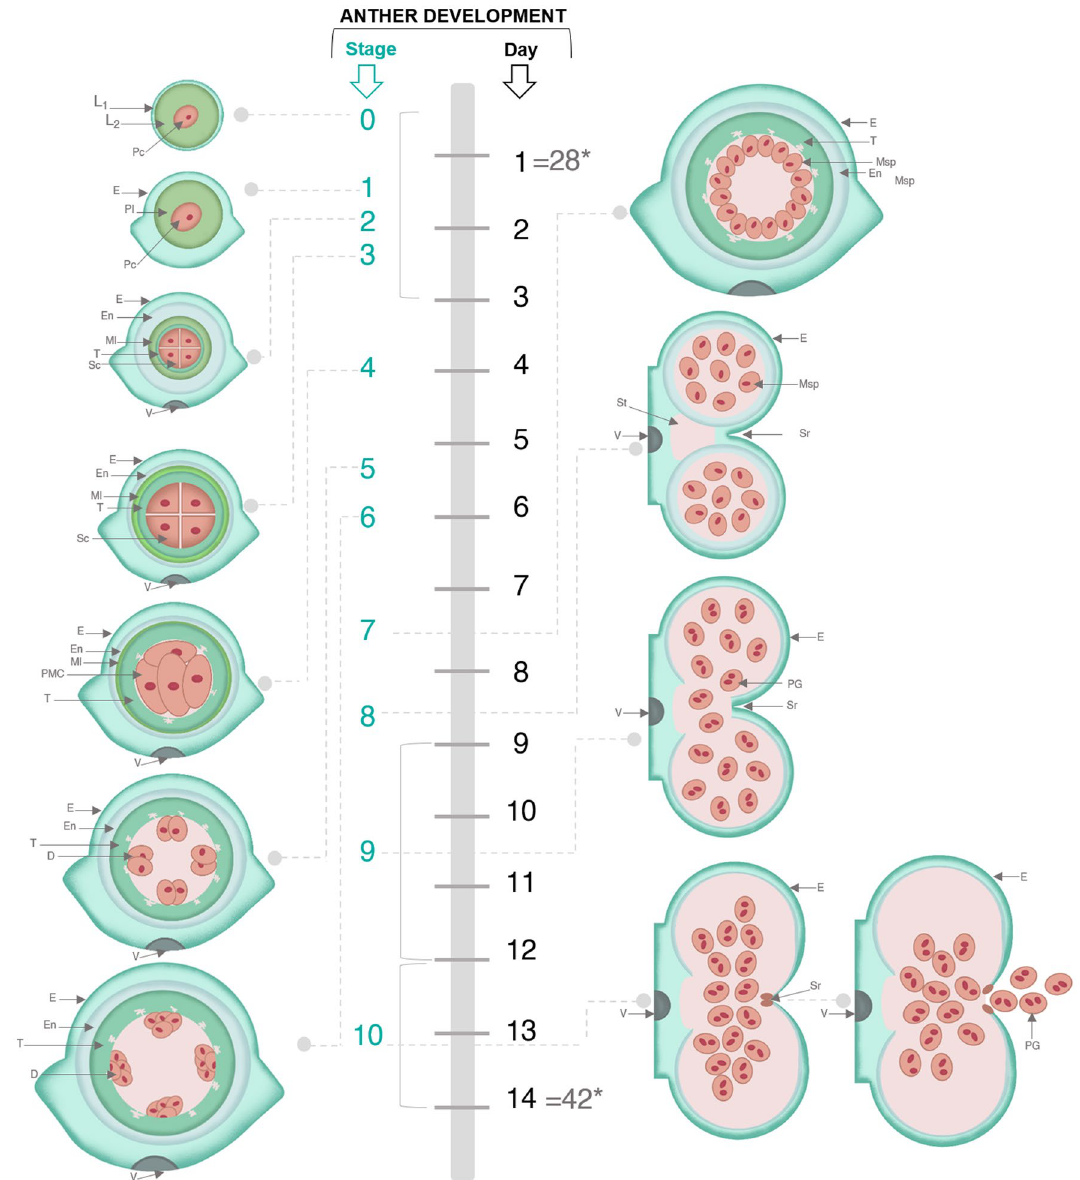
Figure 5. Schematic view of formation of diploid yellow potato anther cell layers. The diagram shows the relationship between the stages of flower bud development and the duration expressed in days. The left side of the figure details the first six stages (0 to 6) of anther development; while the right side of the image shows stages 7 to 10. D Dyads, E epidermis, En endothecium, L1, L2 lines of primordia of the stamen, Ml midline, Msp microspore, Pc procambial cells, PG pollen grain, Pl parietal line, PMC pollen mother cell, Sc sporangial cells, Sr stomium region, St septum, T tapetum, Tds tetrads, V vascular tissue. Asterisk: corresponds to the number of days after emergence. Scheme devised and recreated by the authors with images illustrated by Camila Reyes and Angie